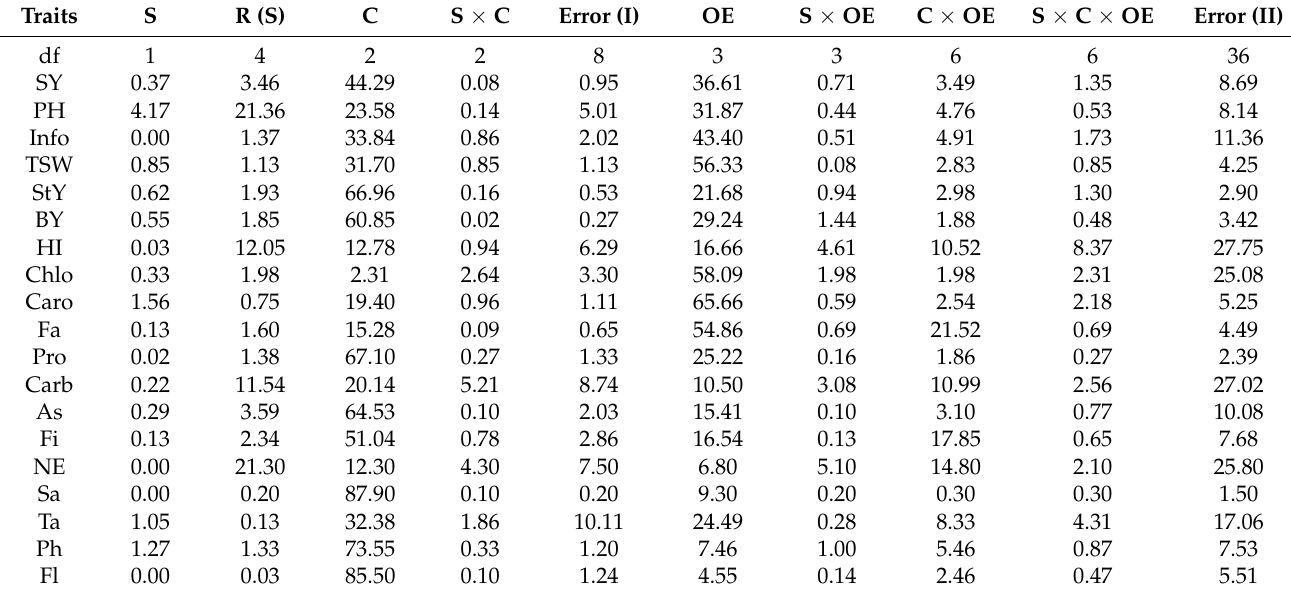
Table 4. Variance components as the percentage of individual sources of variation in the total for studied traits of quinoa cultivars (C) and the organic extracts (OE) tested for two seasons (S).